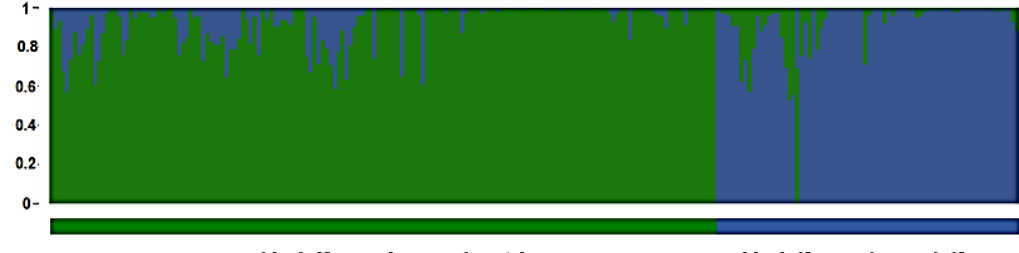
Figure 4. Graphic presentation of the population structure of 243 grapevine accessions. Each accession is represented by a single vertical bar divided into K color segments representing its proportions in the two inferred genetic clusters using STRUCTURE software. Wild accessions grouped into a population represented by green, while cultivated accessions grouped into a population represented by